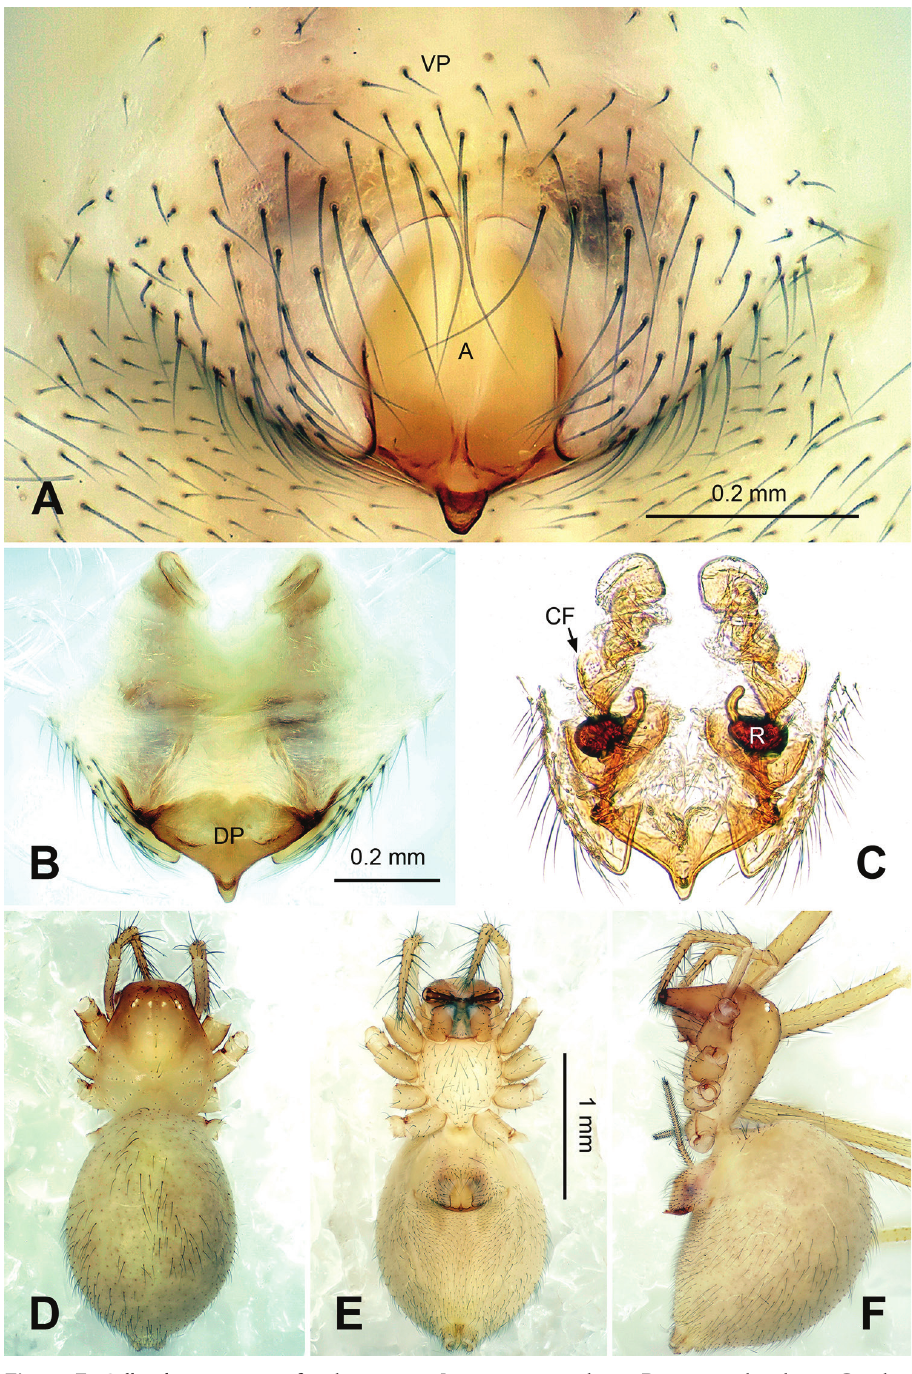
Figure 7. Callosa baiseensis sp. n., female paratype. A Epigyne, ventral view B Epigyne, dorsal view C Vulva, dorsal view D Habitus, dorsal view E Habitus, ventral view F Habitus lateral view. Scale bars: C as B ; D , F as E